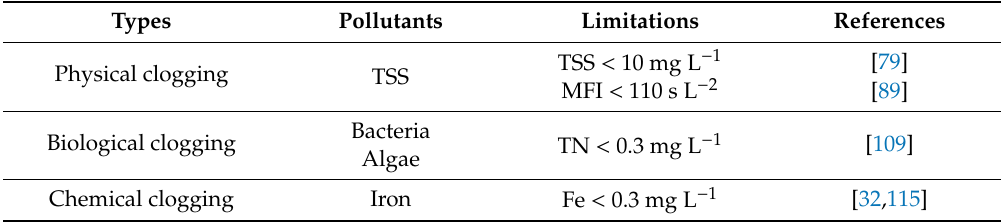
Table 12. Recommended values for basic parameters. MFI: membrane filtration